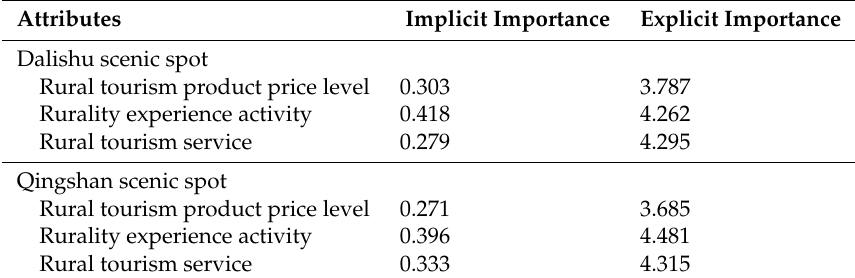
Table 5. Mean implicit and explicit importance ratings of each